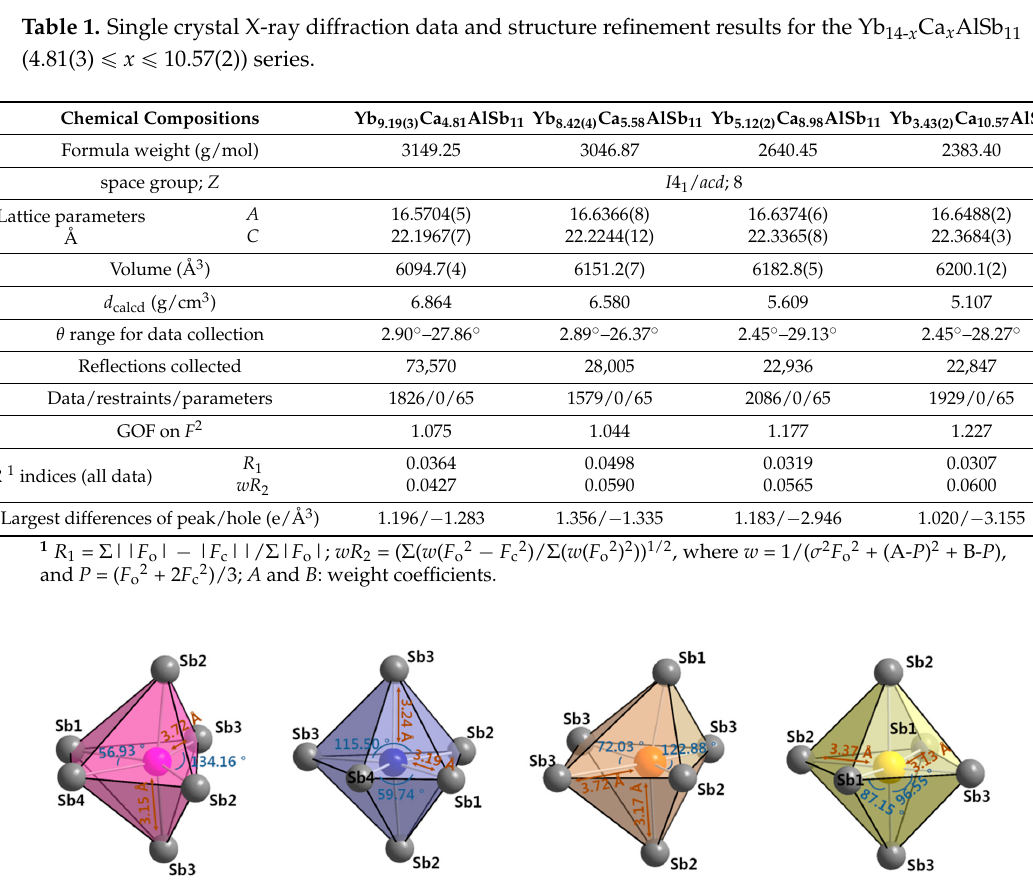
outlined in black, and the color codes are as follows: M , gray; Al, green; Sb, blue.